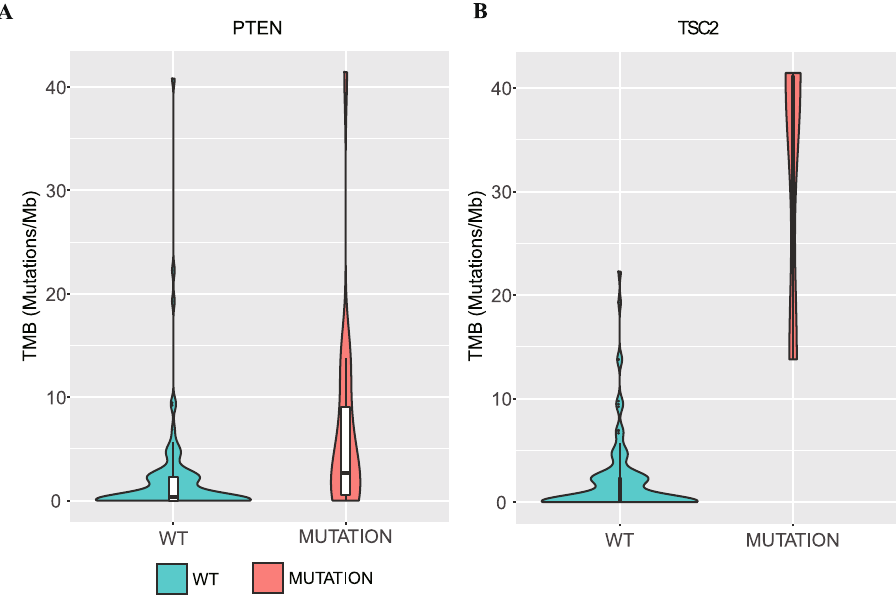
Figure 3. Association of mutations in cancer genes with TMB. ( A ) Plot of mutation burden in specimens with known or likely driver mutations in PTEN (n = 18) and specimens without such mutations (n = 99). ( B ) Plot of mutation burden in specimens with known or likely driver mutations in TSC2 (n = 3) and specimens without such mutations (n =